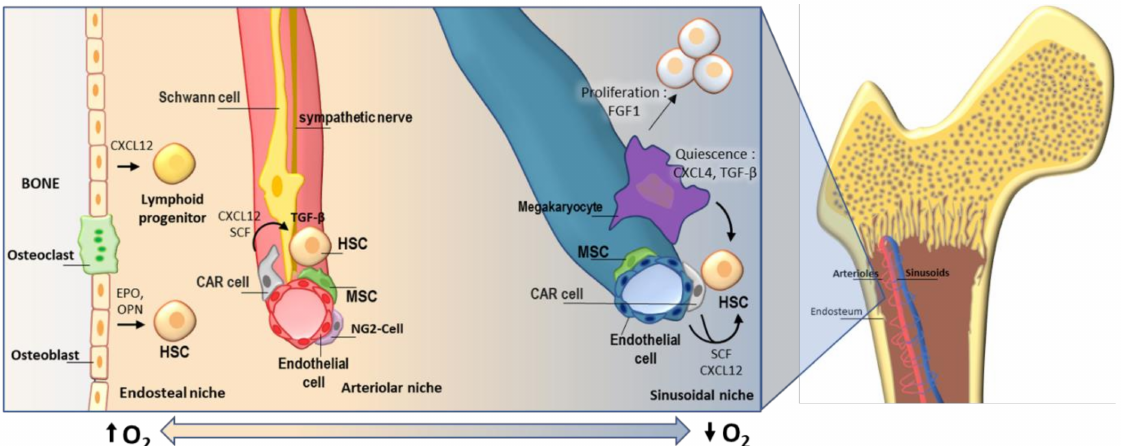
Figure 1. A graphical overview of the bone marrow components and cellular interactions taking place in the bone marrow niche. Chemical and physical characteristics of the bone marrow have effects in HSC be- havior. Oxygen tension, which is considered central to HSC quiescence, is not uniform throughout the bone marrow. Direct measurement of oxygen pressure identified gradual differences, and contrary to common thought, endosteal regions are the most